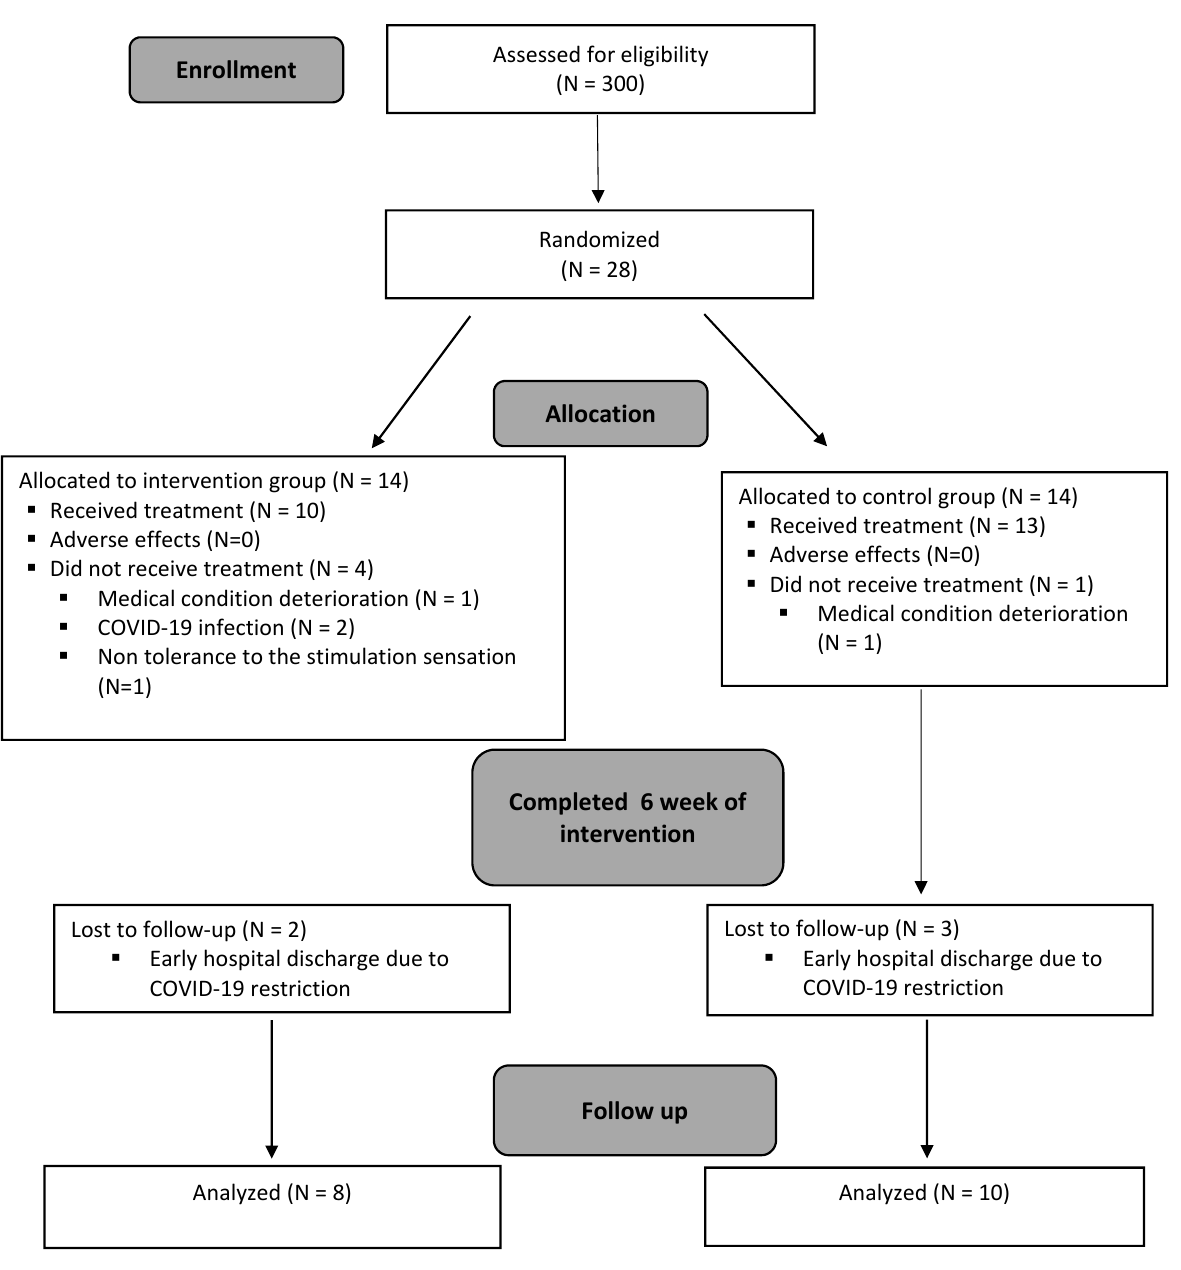
Figure 3. Flowchart of the study